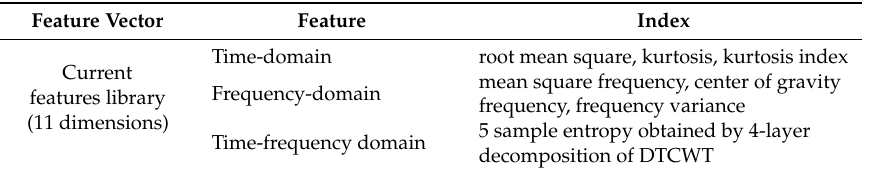
Table 4. The indexes of feature vector for current signal.